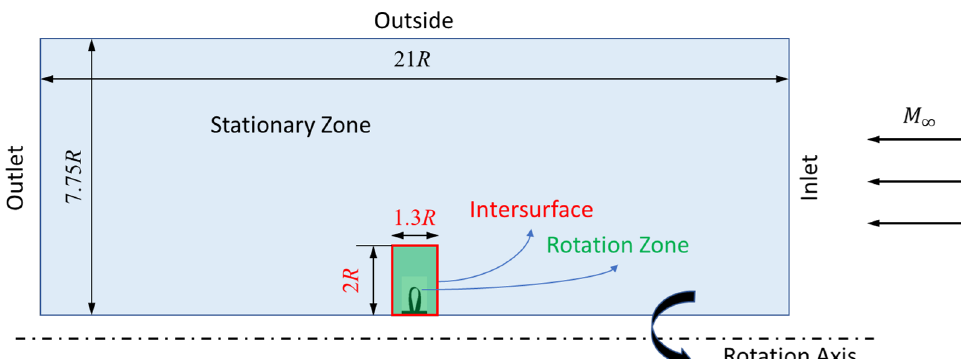
Figure 6. The computational domain in the simulation of the configuration samples in the optimiza- tion, where R stands for the radius of the propeller.